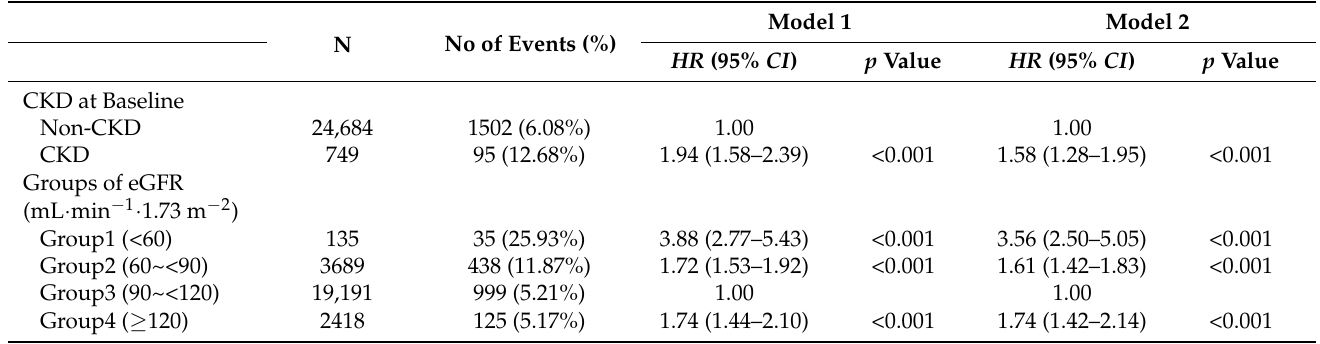
Table 1. Associations between CKD and eGFR at baseline with new-onset HUA.